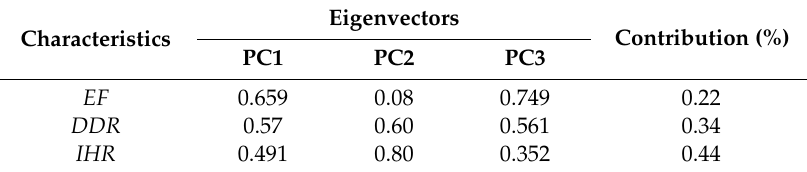
Table 8. Eigenvectors and contributions for the principal components (PC).